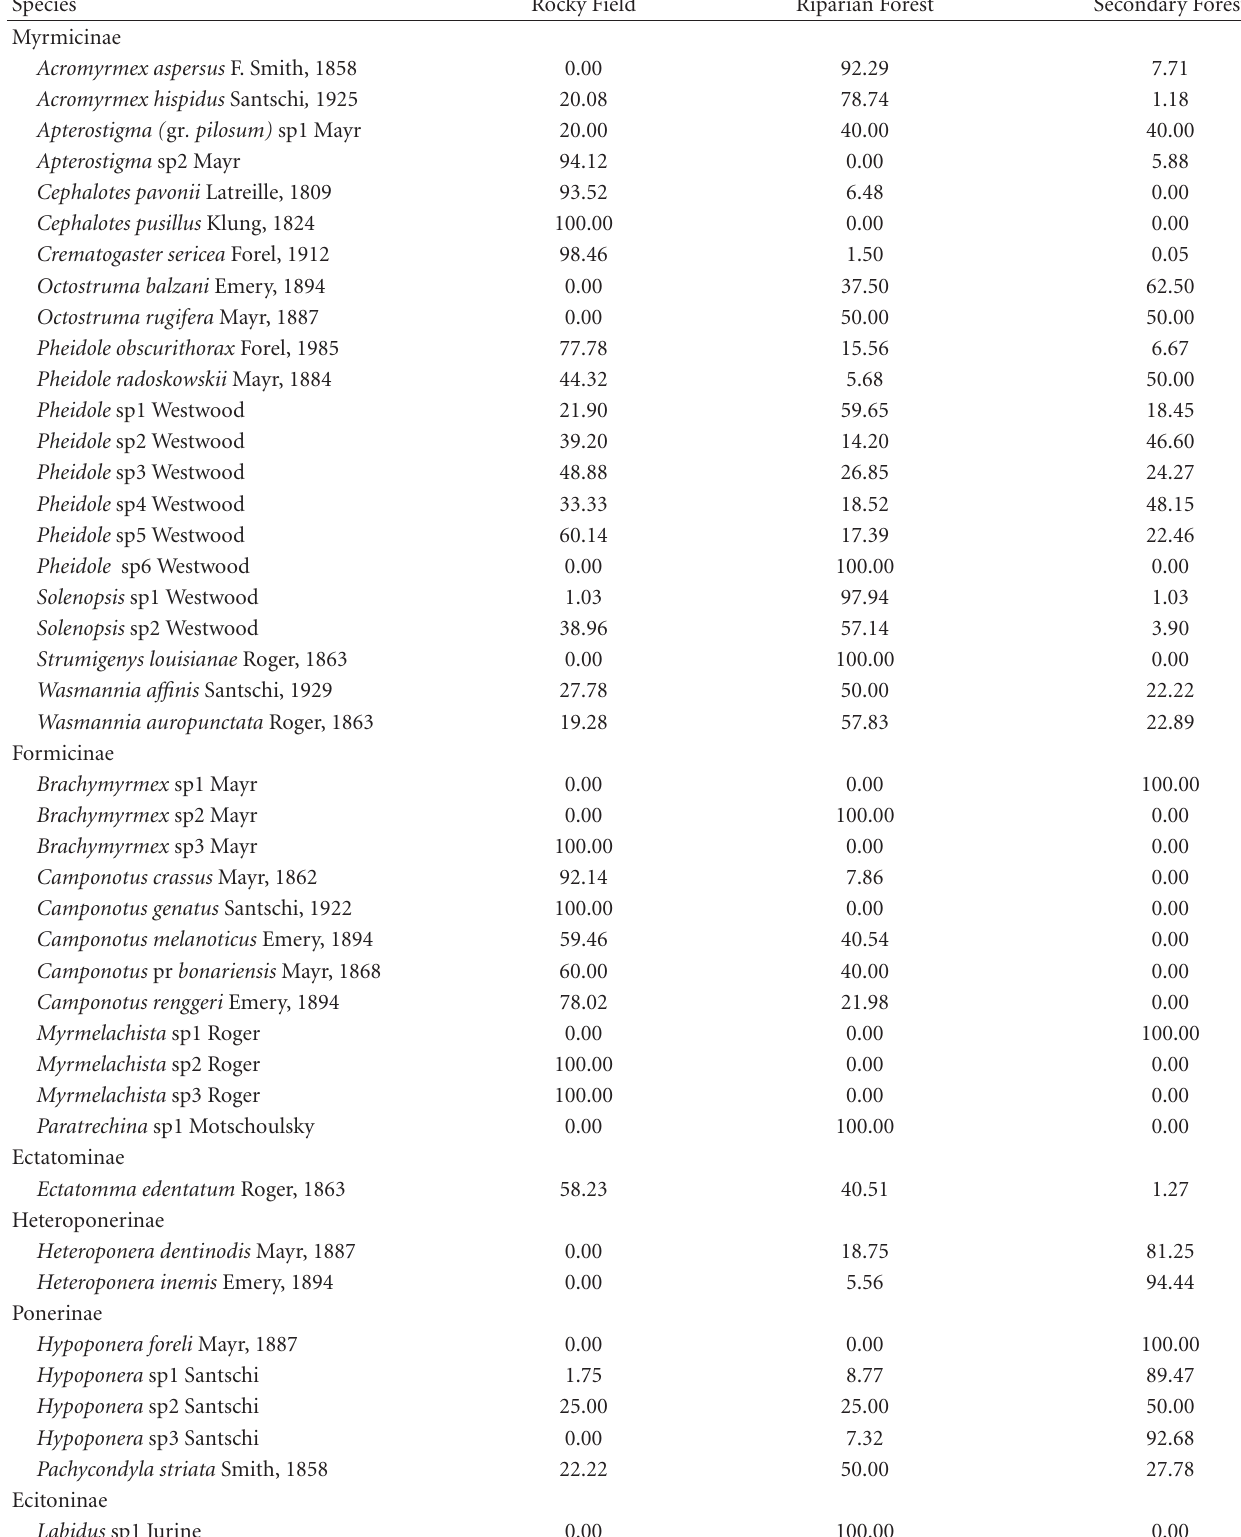
Table 1: Relative frequency of occurrence of ant species in the three phytophysionomies in the Parque Estadual do Ibitipoca, Brazil. July– December, 2008. Species Rocky Field Riparian Forest Secondary